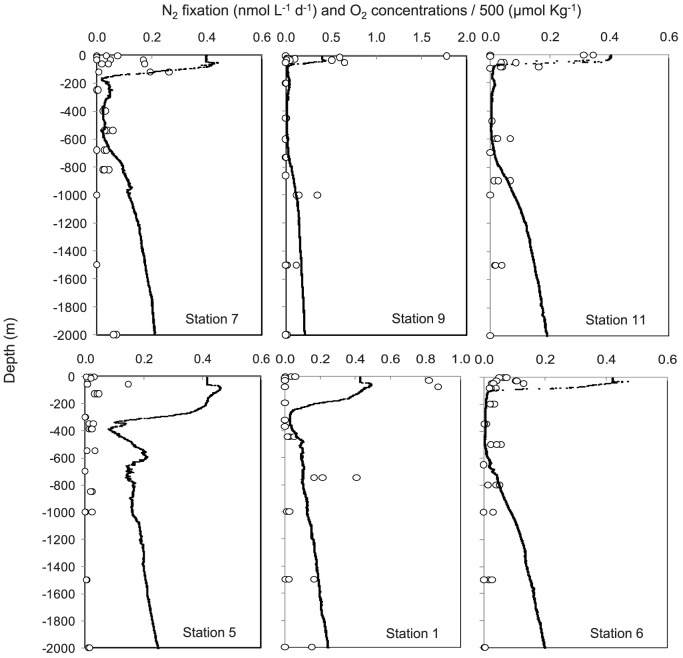
Vertical profiles (0–2000 m) of N2 fixation rates (nmol L−1 d−1) during the 2011 cruise (R/V Melville).Open circles: individual N2 fixation measurements at each depth. Black line: dissolved oxygen concentrations (µmol Kg−1) divided by 500 to fit on the same scale.